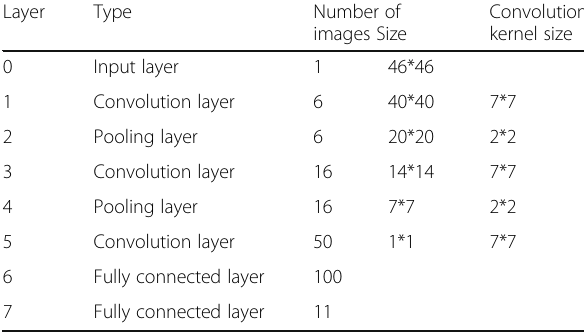
Table 1 Parameter table of convolution neural